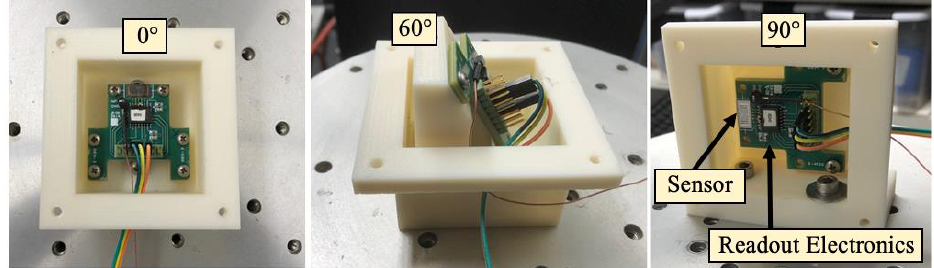
Figure 2. Sensor and electronic readout printed circuit board mounted on the shaker at 0, 60, and 90 degrees.